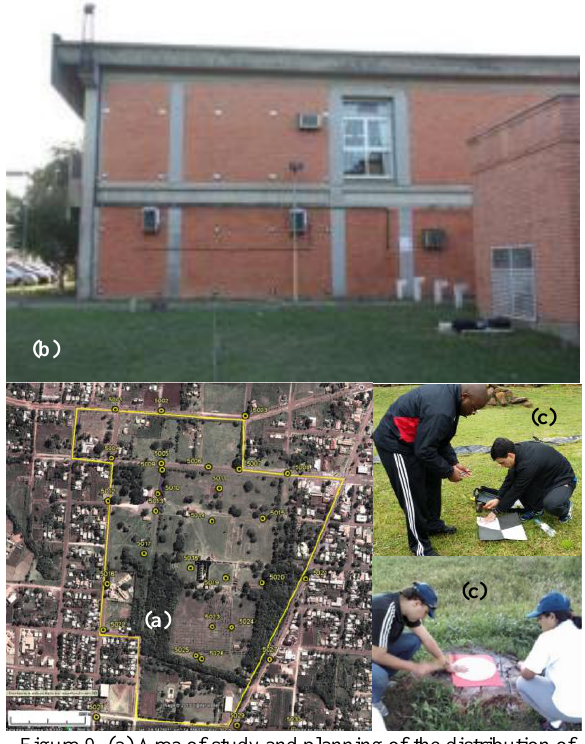
Figure 9. (a) Area of study and planning of the distribution of pre-signalized control points; (b) IGEO camera calibration Wall; (c) Pre-signaling planned control points.